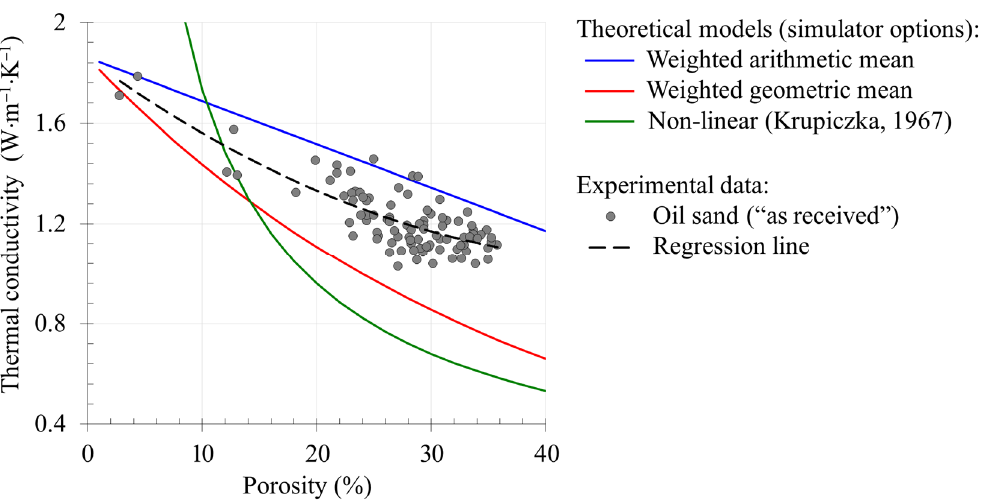
Figure 10. Significant discrepancy between experimental and calculated thermal conductivity data of oil sands of the Karabikulovskoye field; calculation carried out using various simulator options and appropriately defined λ s .